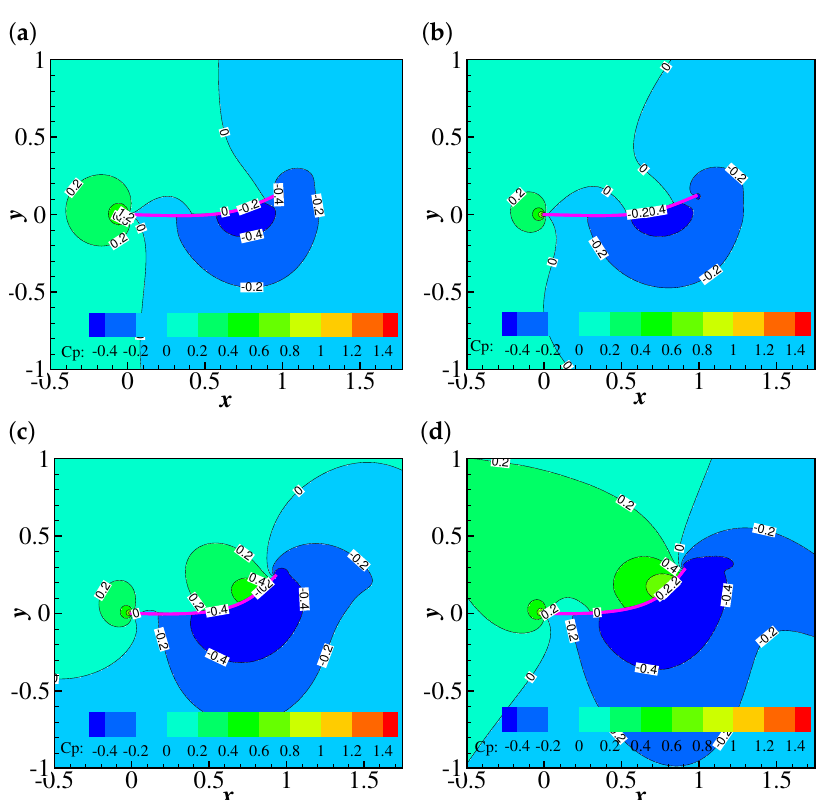
Figure 11. Contours of the pressure coefficient at Re = 100, and Wi = ( a ) 0 (at t = 30.935), ( b ) 0.2 (at t = 30.825), ( c ) 0.6 (at t = 30.605) and ( d ) 1.0 (at t = 30.375).